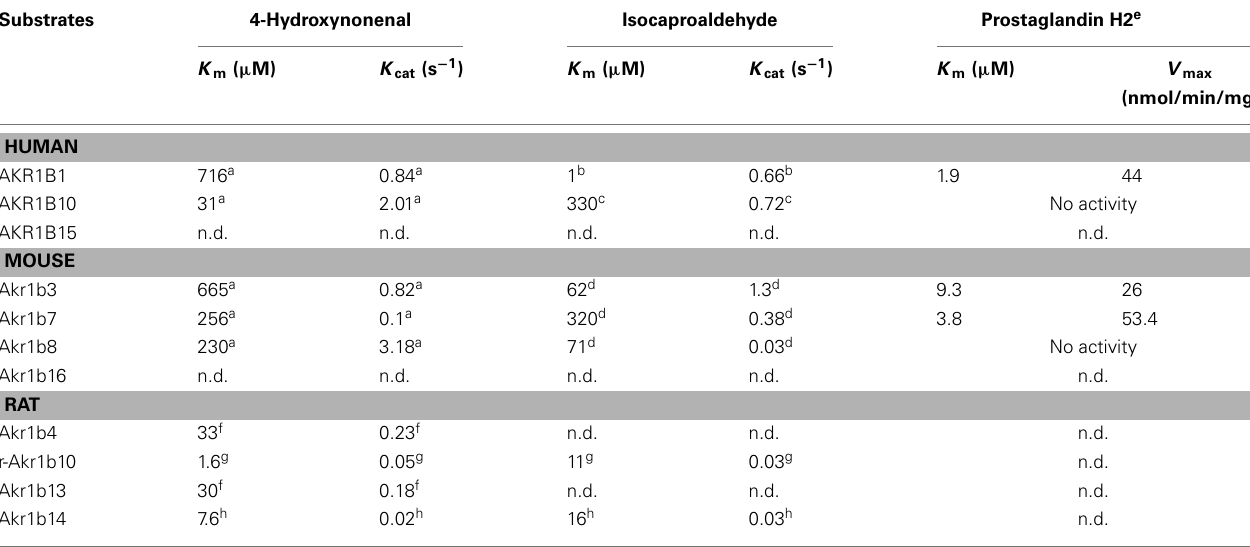
Table 3 | Kinetic constants ofAKR1B toward 4-hydroxynonenal, isocaproaldehyde, and prostaglandin H2.